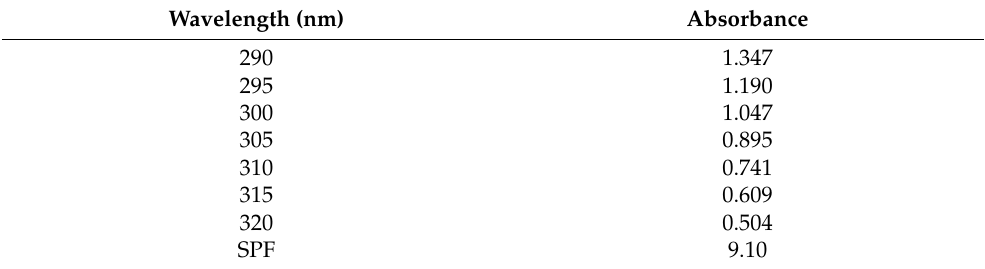
Table 2. Absorbance and sun protection factor (SPF) values of E. characias ethanolic extract.